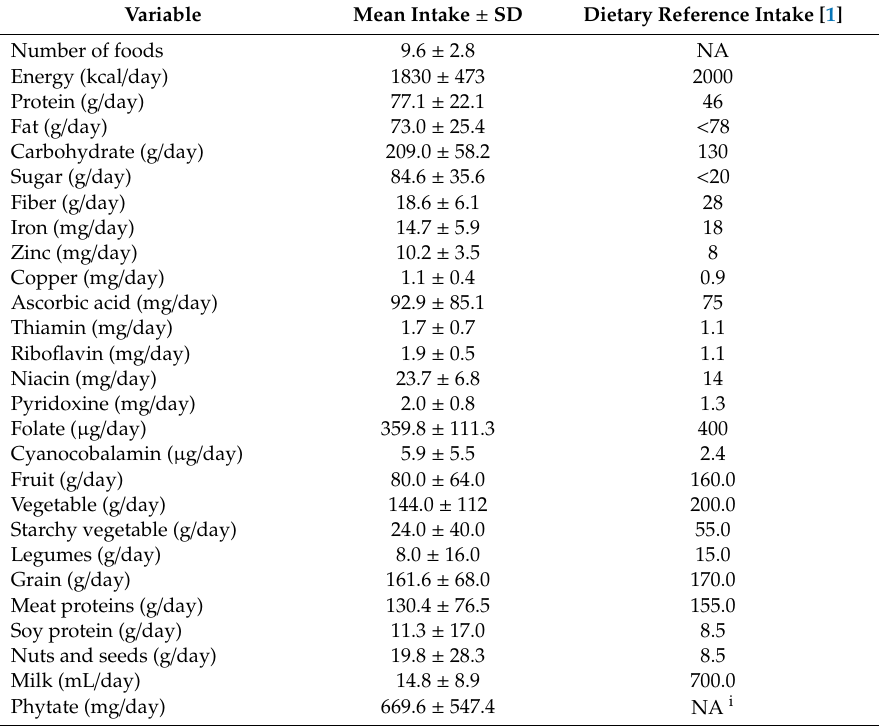
Table 4. Mean nutrient intake from 24 h recall